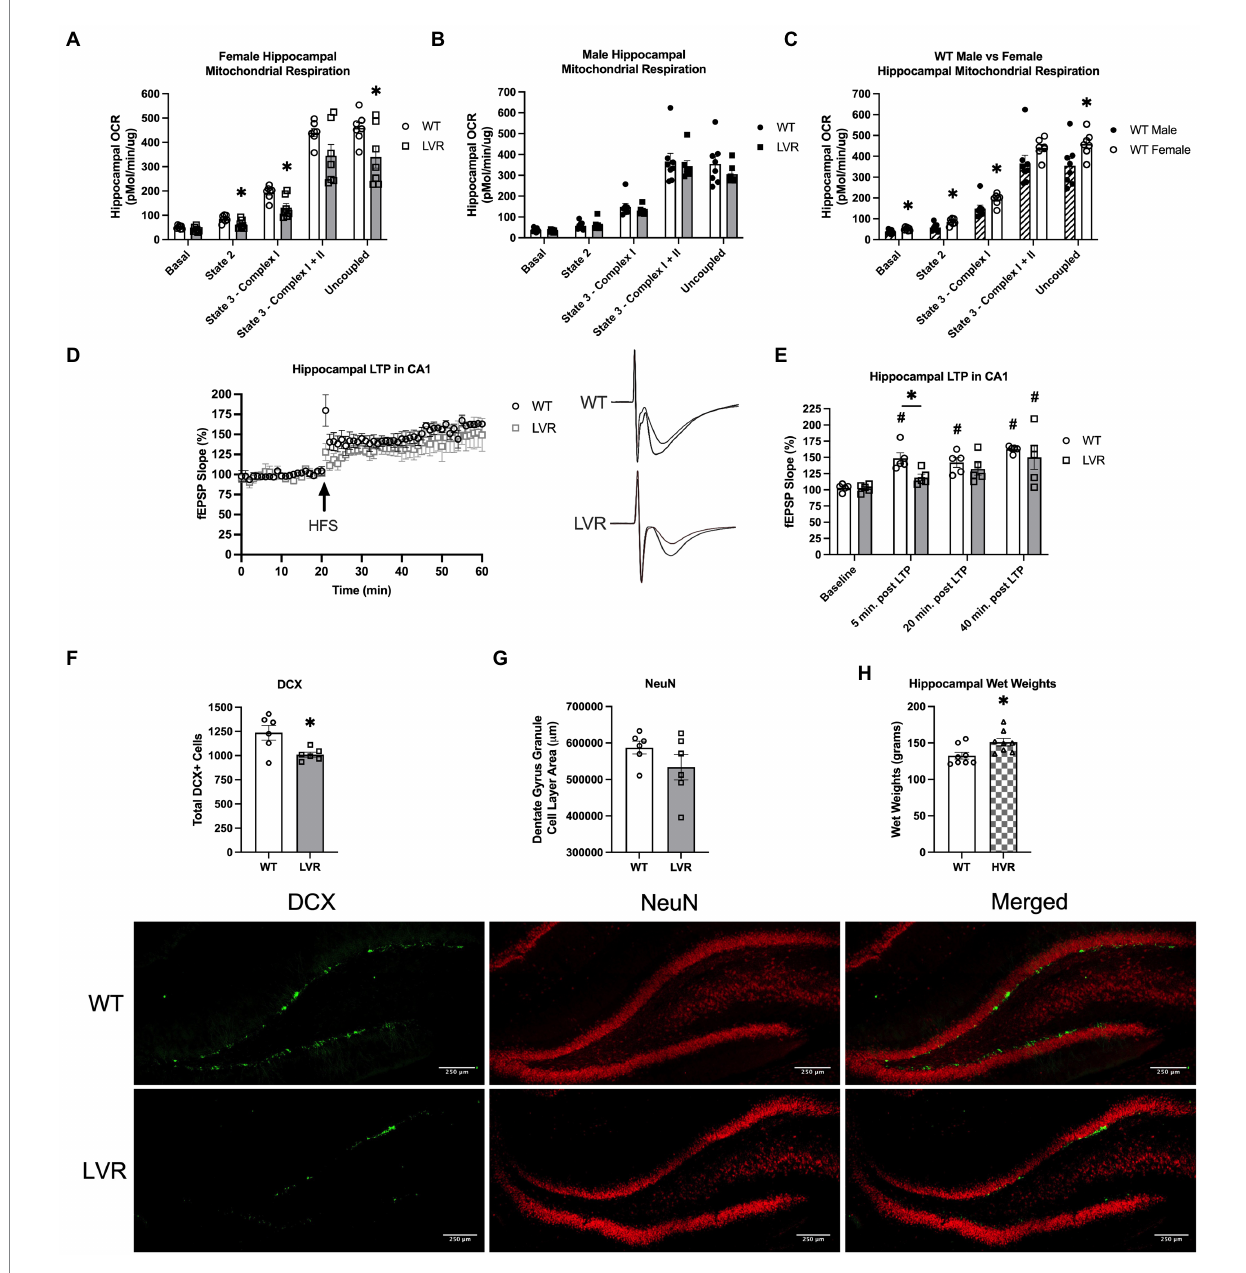
FIGURE 3 Female LVR have deficits in hippocampal mitochondrial respiration, LTP induction, and neurogenesis while HVR have greater hippocampal volume. Oroboros mitochondrial respiration analysis of the hippocampus between (A) female WT (white bars, N = 7) and LVR (gray bars, N = 7), (B) male WT ( N = 8) and LVR ( N = 7), and (C) male (hashed bars) and female WT. (D) LTP recordings in the CA1 region of the hippocampus in female WT ( N = 5) and LVR ( N = 5) with representative traces. (E) Statistical analysis of LTP recordings between female WT and LVR. (F) Number of DCX positive cells in the dentate gyrus of WT ( N = 6, 6 slices per N) and LVR ( N = 6, 6 slices per N). (G) Total area of NeuN staining in the granule cell layer of the dentate gyrus in WT ( N = 6, 6 slices per N) and LVR ( N = 6, 6 slices per N). Representative images of DCX and NeuN staining of the dentate gyrus in female WT and LVR underneath figures (scale = 250 μ m). (H) Hippocampal wet weights in female WT ( N = 8) and HVR ( N = 8). * Denotes significant difference between groups based on Student’s t -test. # Denotes significant post-hoc difference relative to within group baseline. Values expressed as mean +